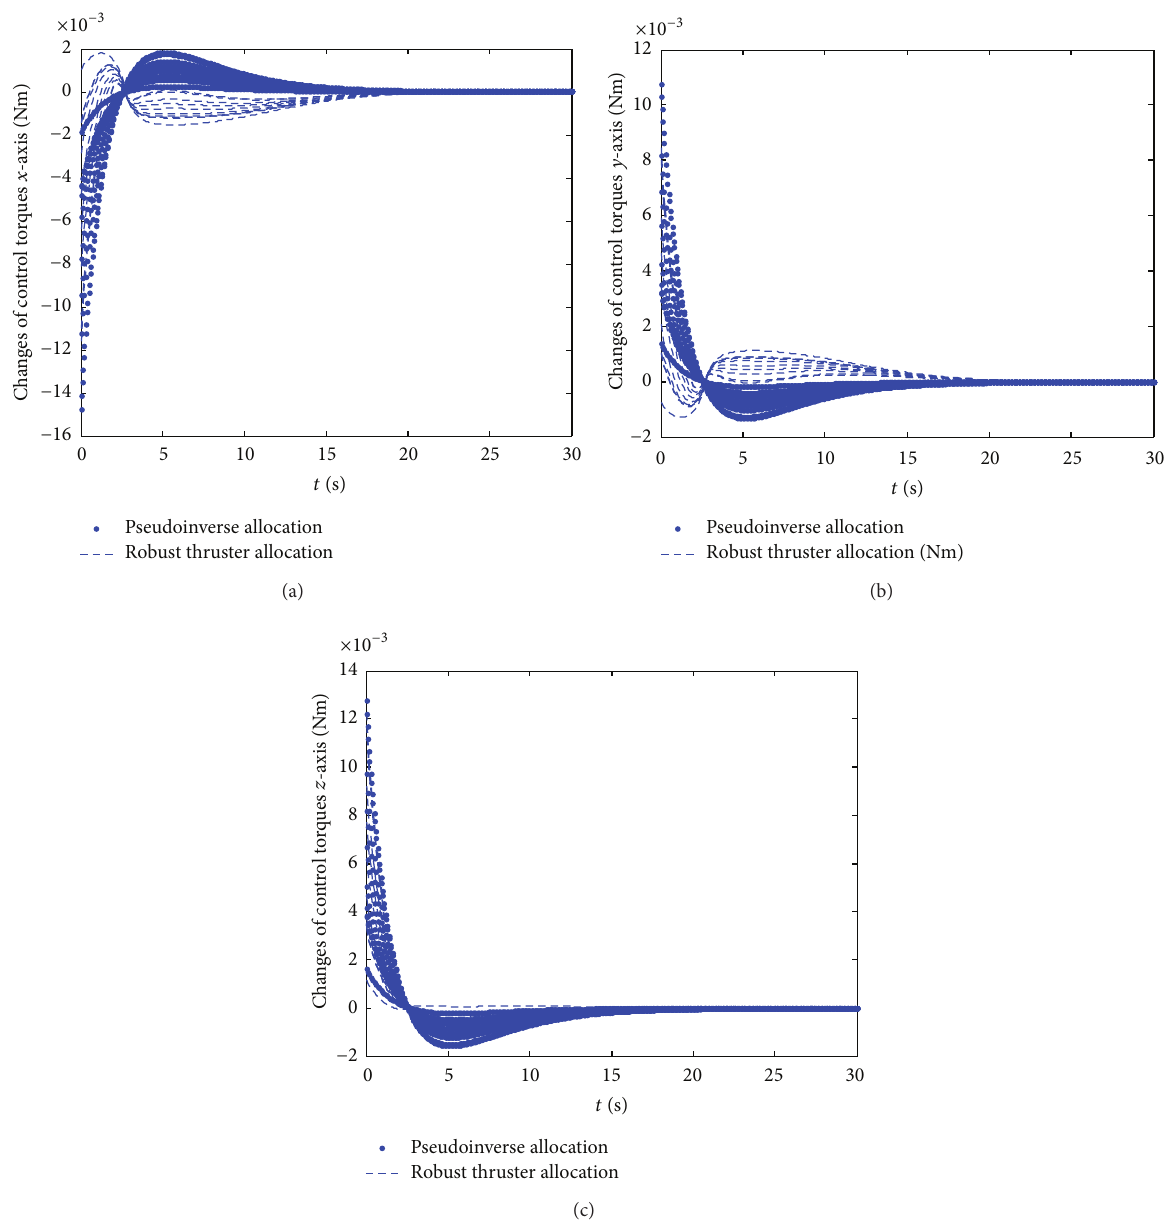
Figure 6: The curves of torque distribution deviation when the control efficiency matrix is with the uncertainty of 10%.